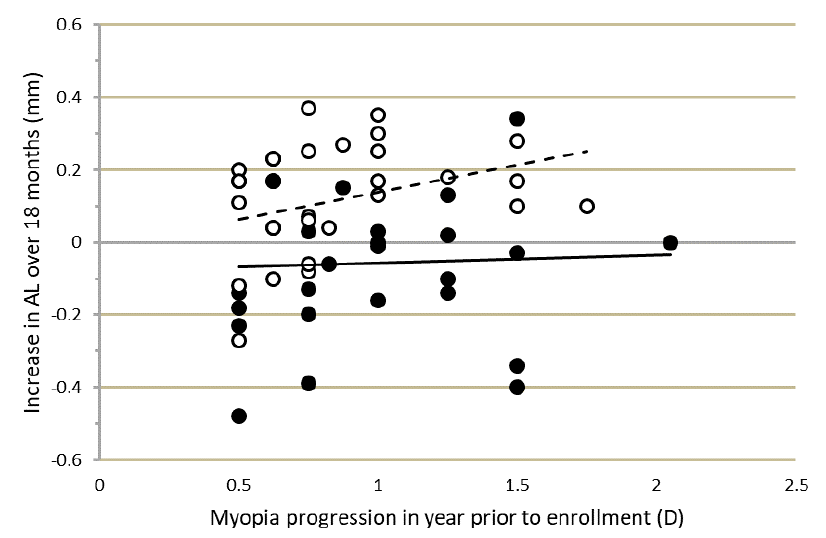
Figure 3. Correlation between the change in axial length (AL) over 18 months of lens wear vs. myopia progression in the year prior to enrollment. Filled circles and solid line: multifocal orthokeratology (MOK) treated eyes: n = 28, R 2 = 0.002, p = 0.83. Open circles and dashed line: orthokeratology (OK) treated eyes: n = 28, R 2 = 0.114, p = 0.08.